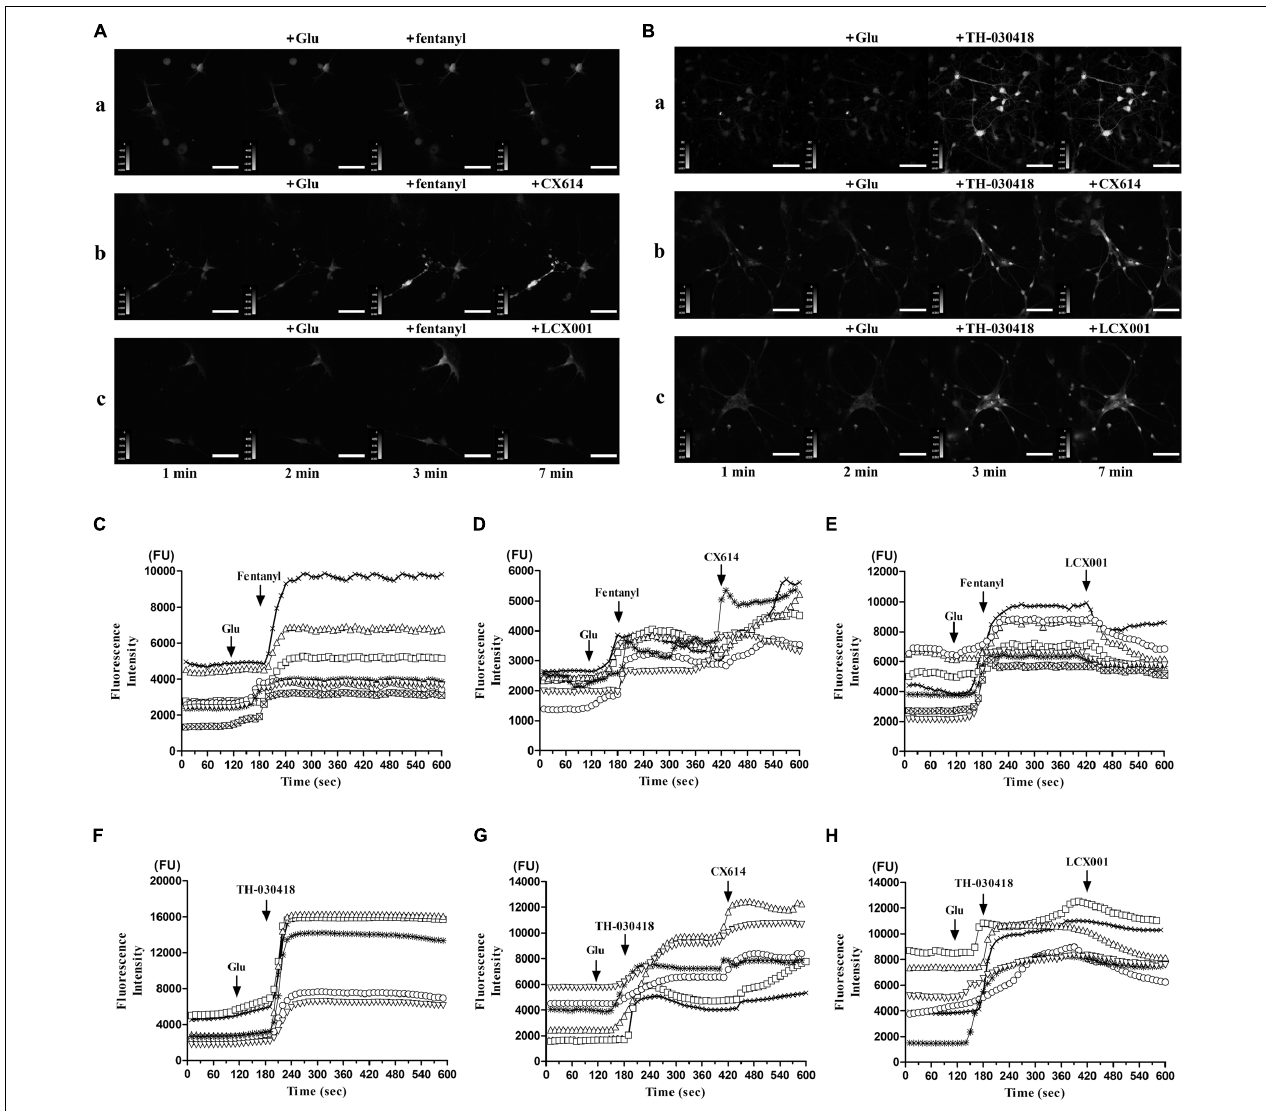
FIGURE 6 | Variation of intracellular calcium concentration ([Ca 2 + ] i ) in response to opioid drugs and following application of LCX001 or CX614. Each trace in this figure was representative to continuous recording of a specific neuron by live cell imaging for 10 min. (A,B) Representative time courses of intracellular calcium fluorescence intensity were measured in Fluo-4 NW dye buffer-loaded primary cultured medulla oblongata neurons, Scale bar = 70 µ m. The neurons were treated with glutamate, fentanyl/TH-030418 and LCX001/CX614 consecutively. Final compound concentrations and time points of application: glutamate (18 µ M, 2 min), fentanyl or TH-030418 (42 µ M, 3 min), then LCX001 or CX614 (40 µ M, 7 min). (C–E) fentanyl caused a rapid rise in fluorescence intensity and [Ca 2 + ] i , which was blocked by LCX001 treatment and enhanced by CX614. (F–H) TH-030418 triggered an increase in fluorescence intensity and [Ca 2 + ] i . The typical [Ca 2 + ] i rise was prolonged in response to CX614. In contrast, application of LCX001 was instrumental in suppressing the high level of [Ca 2 + ] i . The time-lapse imaging was set at 1 s intervals for 10 min, n =